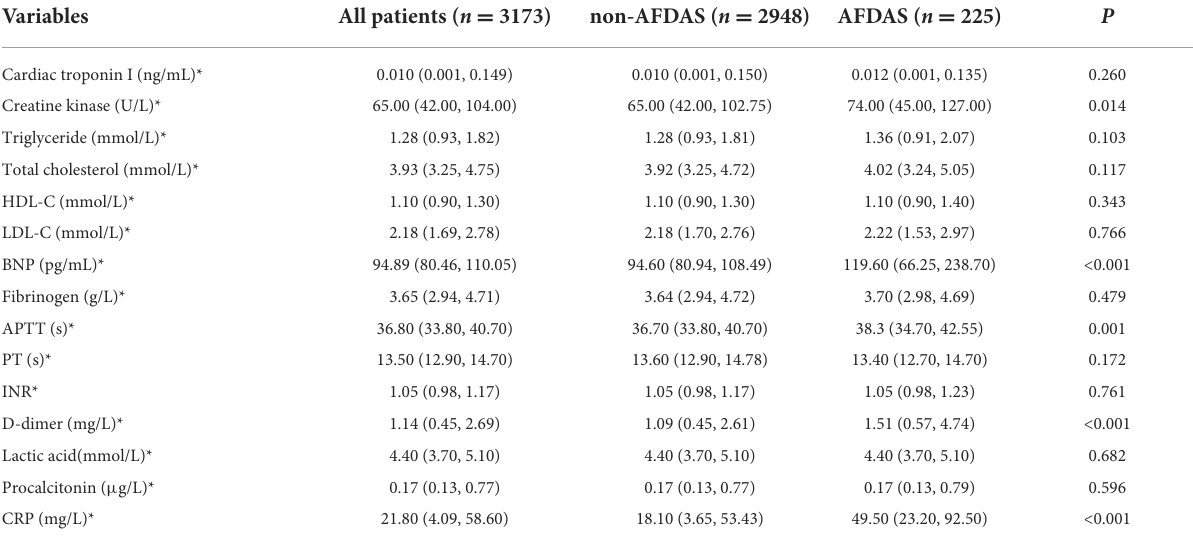
cohort, 2948 (92.9%) had non-AFDAS and 225 (7.1%) had AFDAS. Baseline characteristics were shown in Table 1. Among the different subtypes of TOAST typology, 317 (5.95%) patients with large-artery atherosclerosis had AF, of which 313